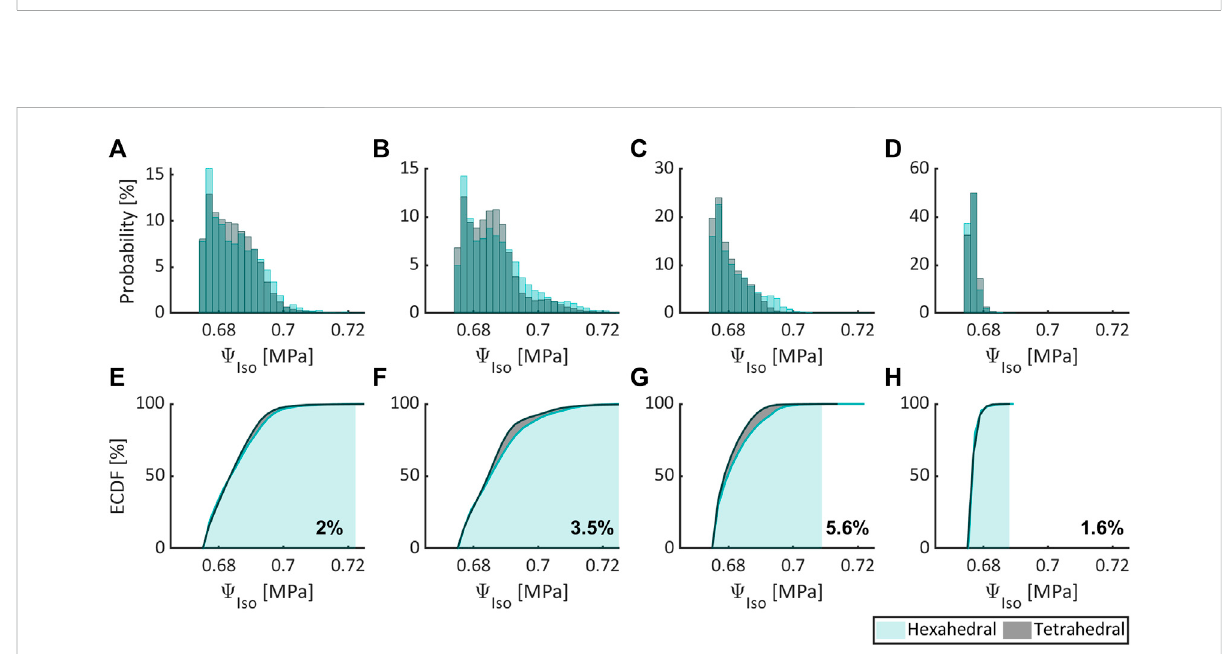
FIGURE 6 Comparing the isotropic contribution to the SEDF expressed as probability (normalized histogram) and ECDF for fl exion (A,E) , extension (B,F) , lateral bending (C,G) , and axial rotation (D,H) for HE and TE types.